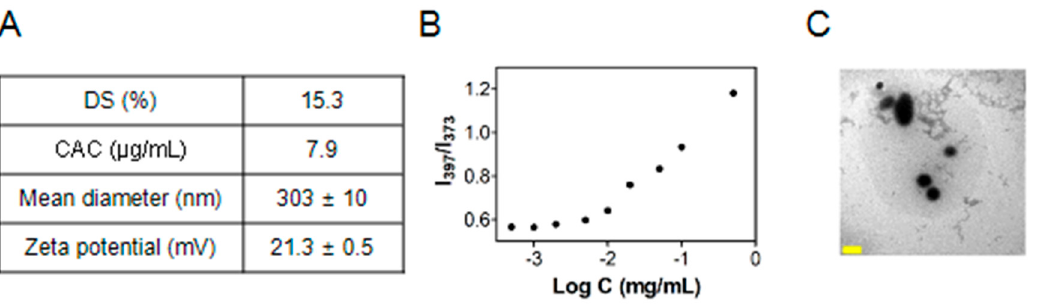
Figure 3. Particle properties of CHS-CS NPs. ( A ) Particle characterization of CHS-CS NPs. ( B ) Critical aggregation concentration (CAC) determination of CHS-CS. I 397 / I 373 values according to log C are plotted. ( C ) Transmission electron microscopy (TEM) image of CHS-CS NPs. The length of the yellow bar included in the image is 200 nm.